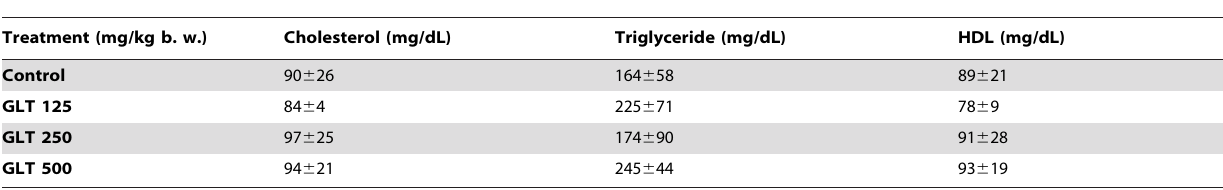
Table 4. Effect of GLT on the lipid metabolism.